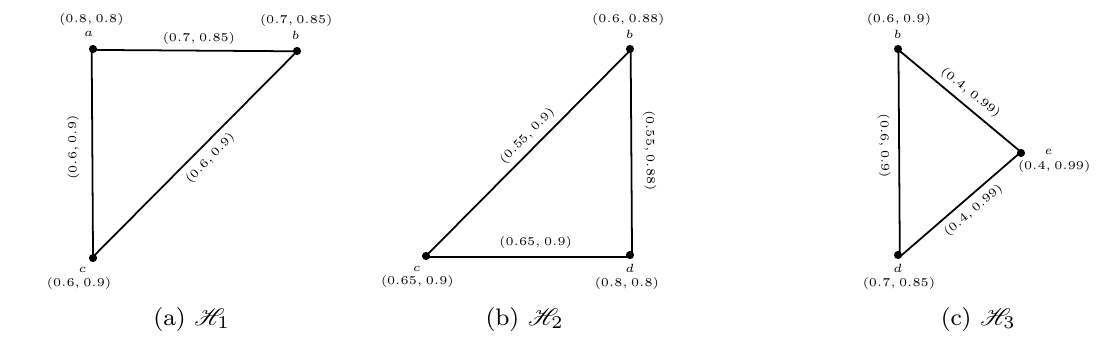
Figure 8. A 4-rung orthopair fuzzy graph G . Figure 3.6: A 4-rung orthopair fuzzy graph G